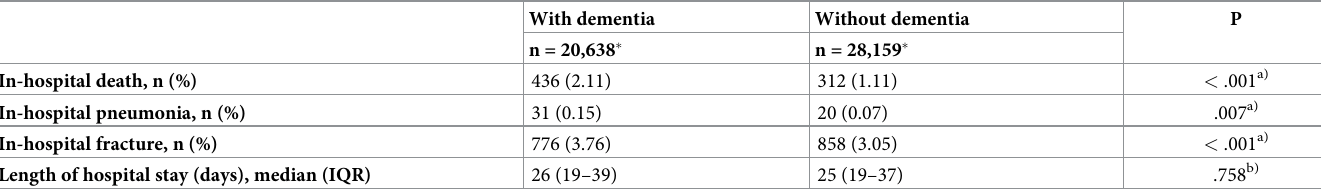
Table 3. Length of hospital stay and prevalence of outcomes in people with and without dementia.